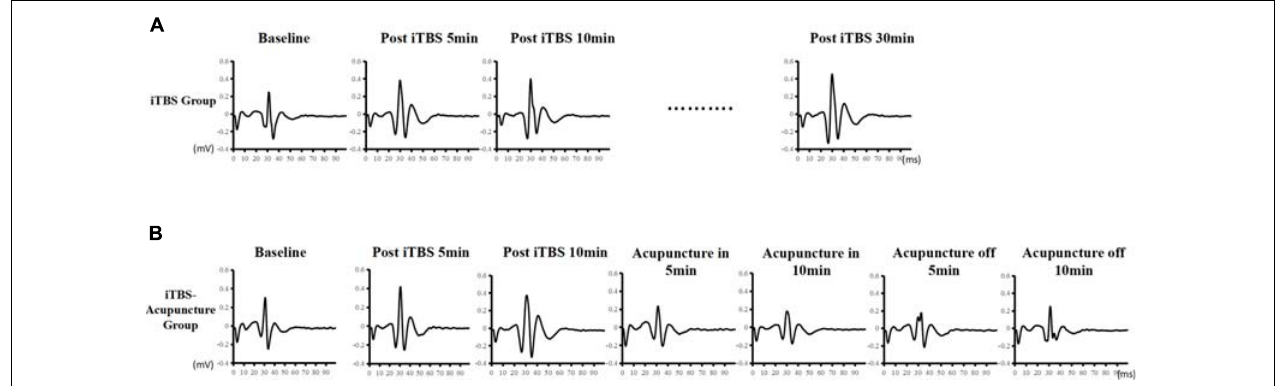
FIGURE 3 | Effect of iTBS and acupuncture on MEPs. Time-course changes of MEPs following iTBS in panel (A) and iTBS and subsequent acupuncture intervention in panel (B) . Representative MEP traces following iTBS present an apparent increase, whereas there are traces of a decrease in MEP amplitude after subsequent acupuncture